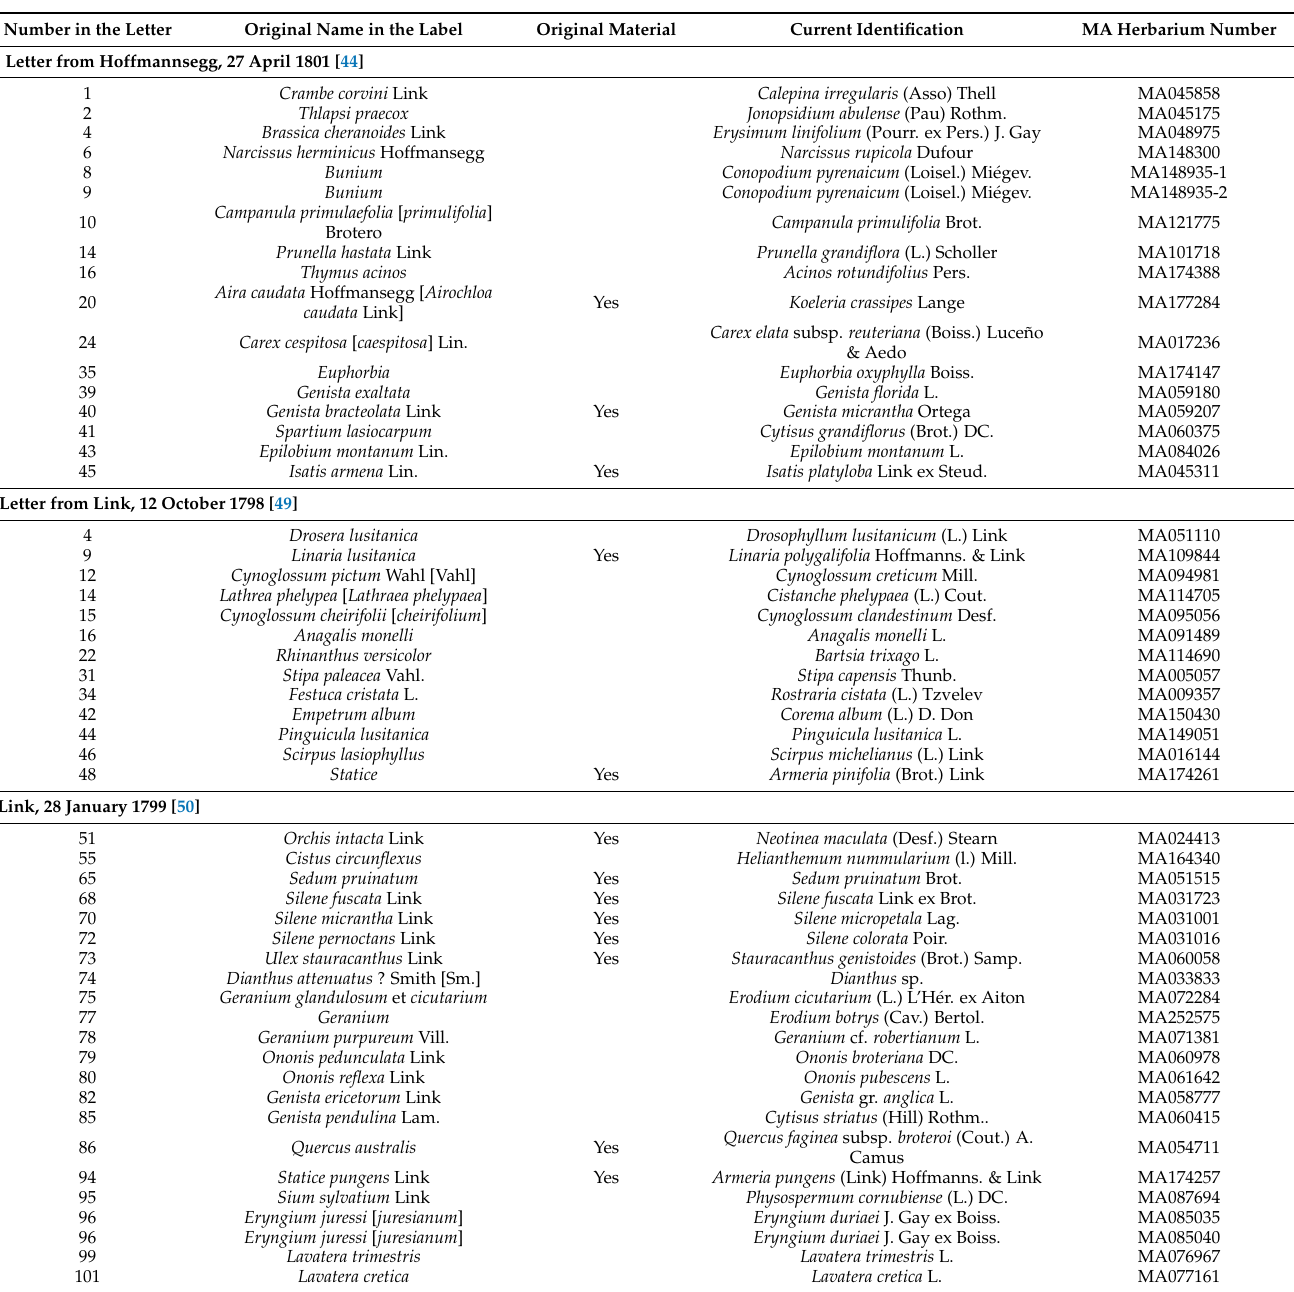
Table 1. Plants in the Herbarium MA of the Real Jard í n Bot á nico of Madrid, sent by J.C. Hoffmannsegg and J.H. Link to A.J. Cavanilles, from their expedition to Portugal (1797–1801). Specimens are sorted by its mention in each letter of reference, with those without a letter of reference at the end. Subsequently ordered by the ordinal in the original letter or in the label. Names or author corrections are between brackets. Original materials, current identification and the MA herbarium number is